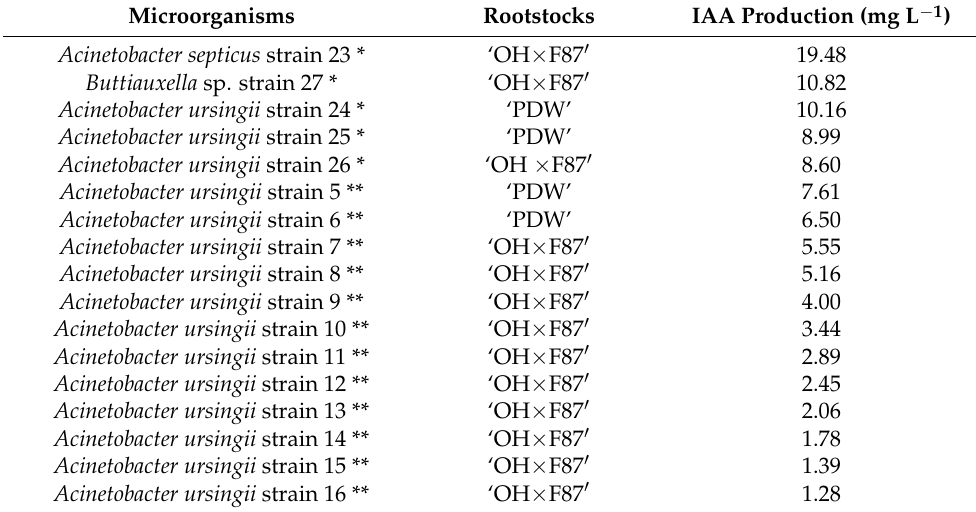
Table 1. Production of auxin by bacteria isolated from pear ( Pyrus communis ) rootstocks ‘OH × F87 (cid:48) an ‘PDW’.